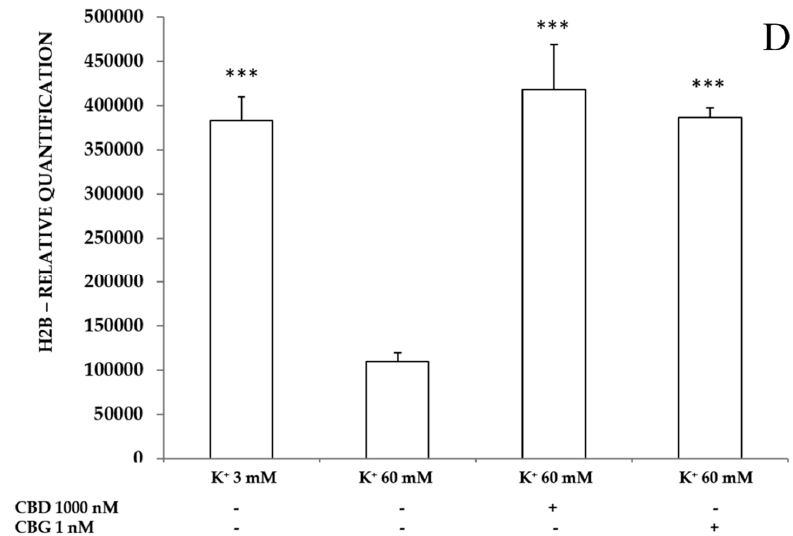
Figure 7. Inhibitory effects of CBD 1000 nM and CBG 1 nM on K + 60 mM-induced reduction in Syt 1 (panel A ), Stx 1b (panel B ), CAMK2A (panel C ) and H2B (panel D ) levels (expressed as Relative Quantification: R.Q.), in isolated rat cortexes ( n = 3 for each experimental condition). (Panel A